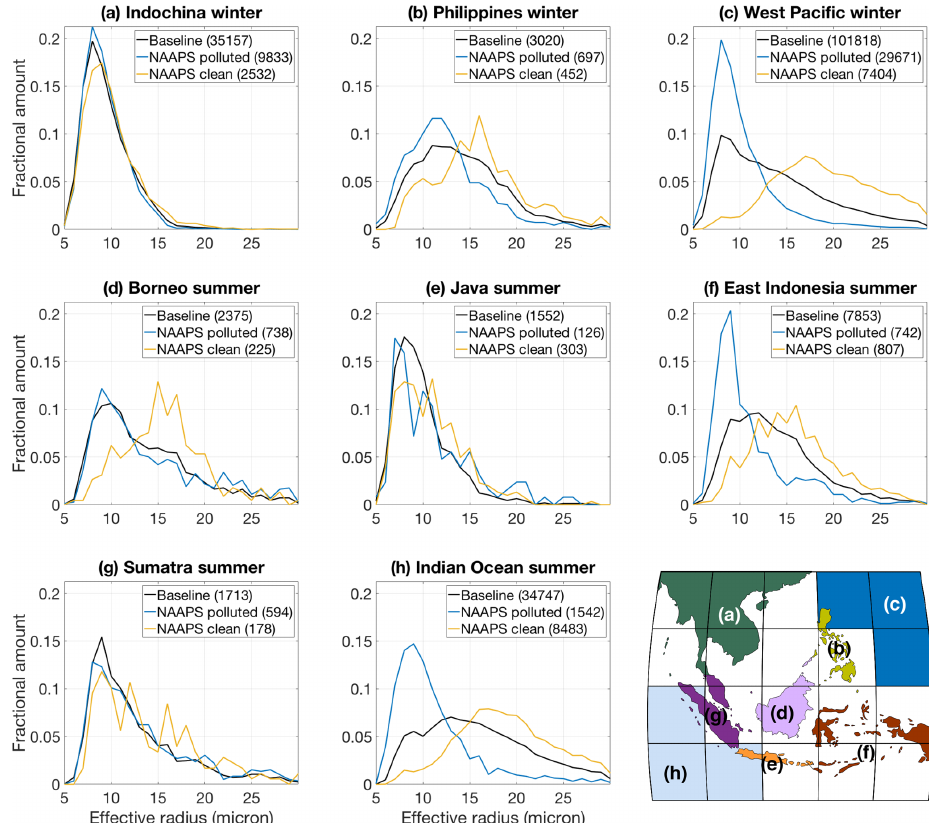
Figure 8. Normalized distributions of MODIS effective radius for baseline, polluted, and clean retrievals showing six regions in panels (a) through (h) : Indochina, the Philippines, and the western Pacific Ocean during winter and Borneo, Java, East Indonesia, Sumatra, and the Indian Ocean during summer. Each panel has the same x and y axis scales, where the y axis shows the fractional amount of clouds. Counts of each population are shown in parentheses in the legends. A map in the lower left is provided as a reference to show each